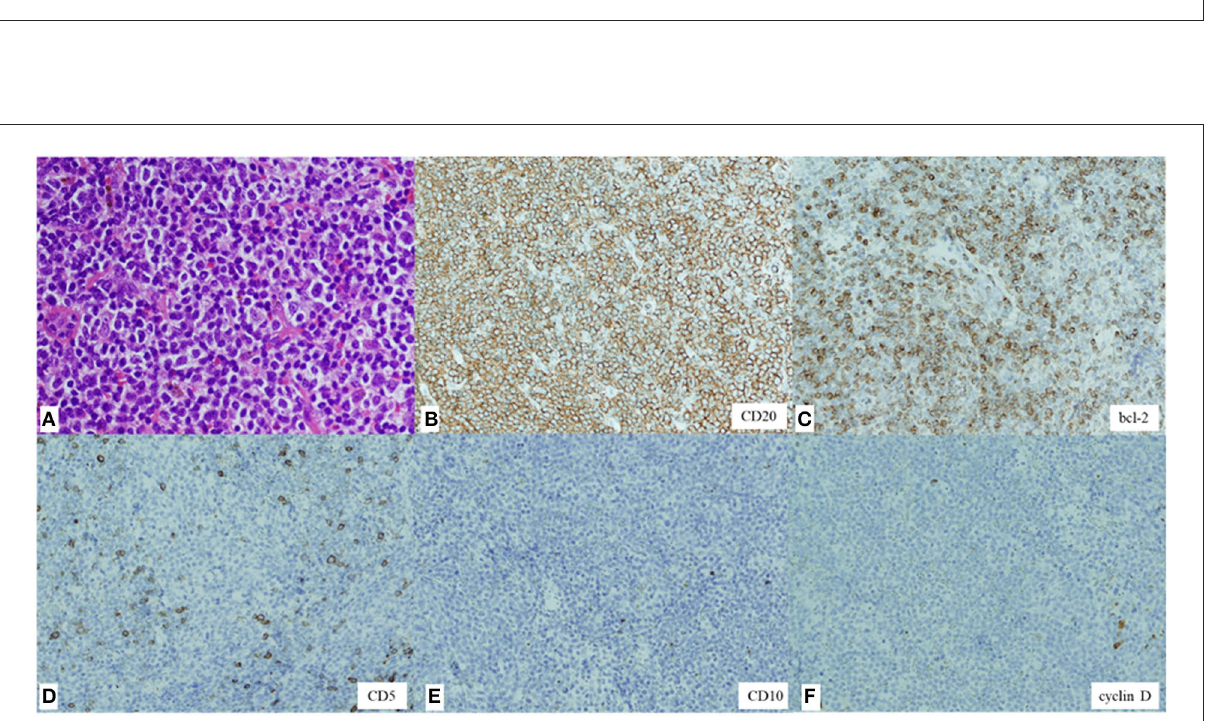
FIGURE4 Hematoxylin and eosin staining of the biopsy specimen showing diffuse proliferation of small- to medium-sized lymphoid cells with slightly enlarged round nuclei (magnification, × 200) (A) . Immunohistochemical staining showing lymphoid cells positive for CD20 ( × 100) (B) and bcl-2 ( × 100) (C) and negative for CD5 ( × 100) (D) , CD10 ( × 100) (E) , and cyclin D ( × 100) (F)